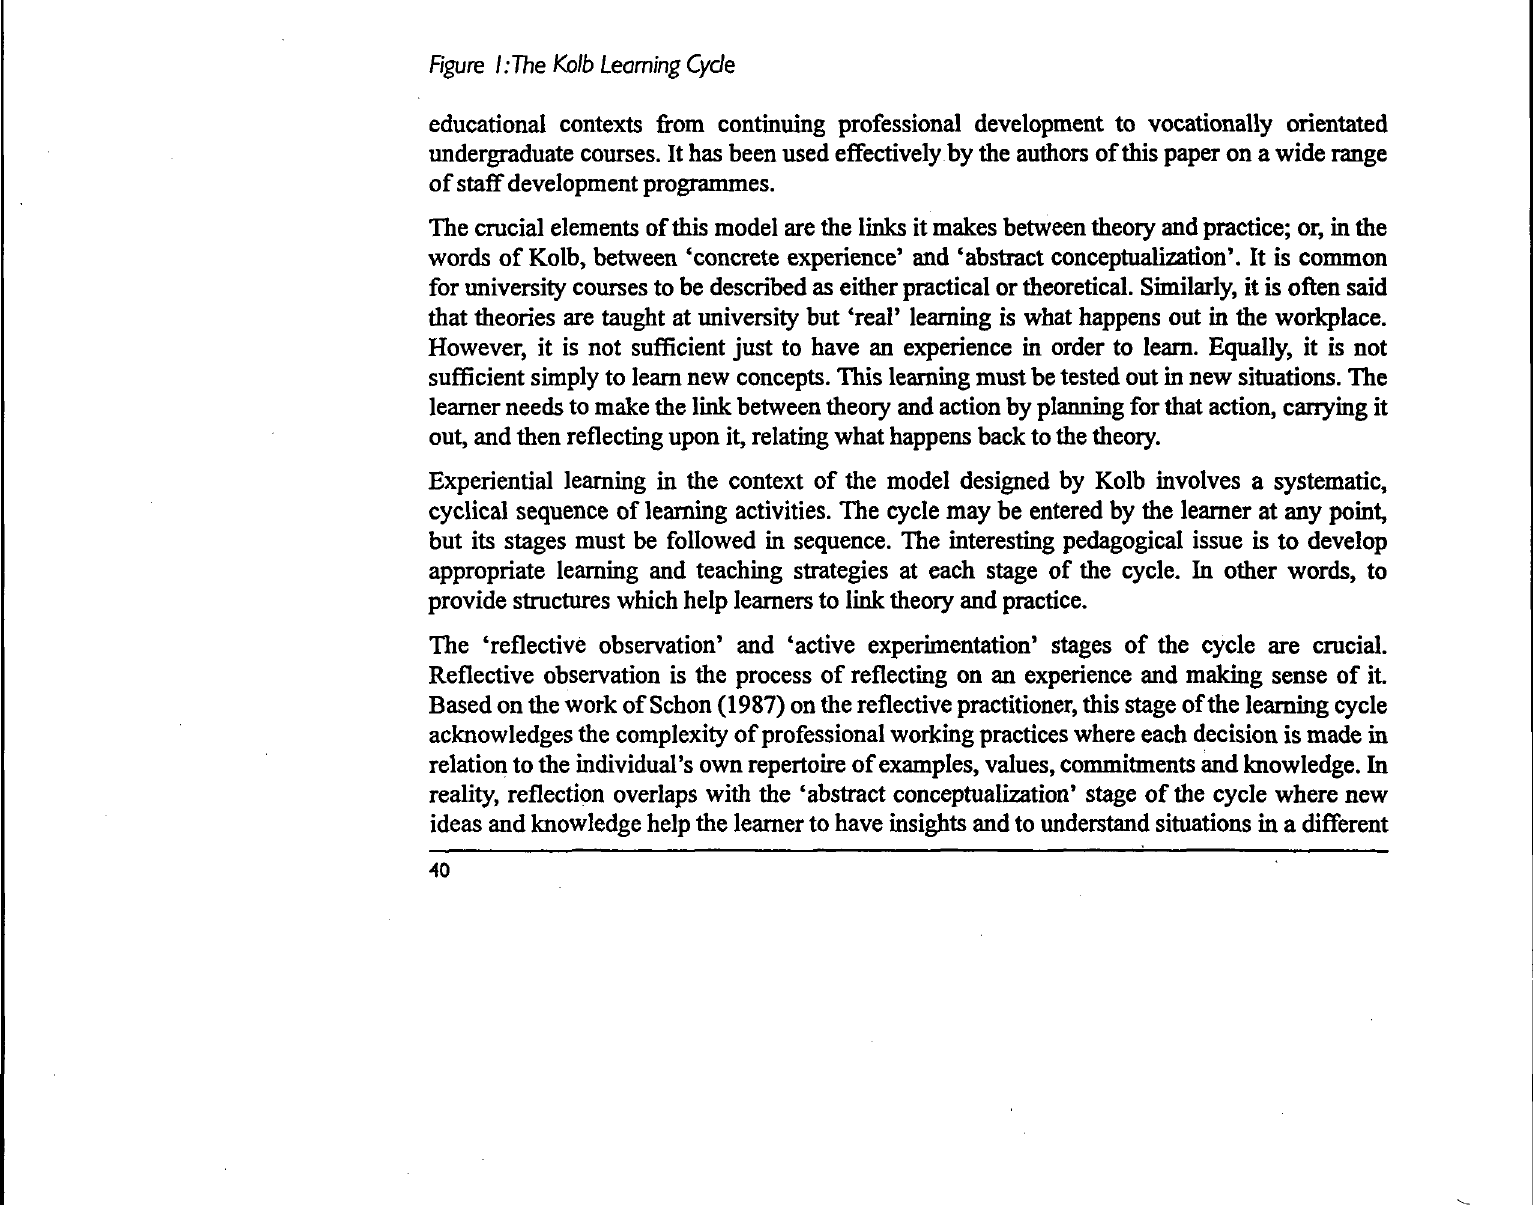
Figure l:The Kolb Learning